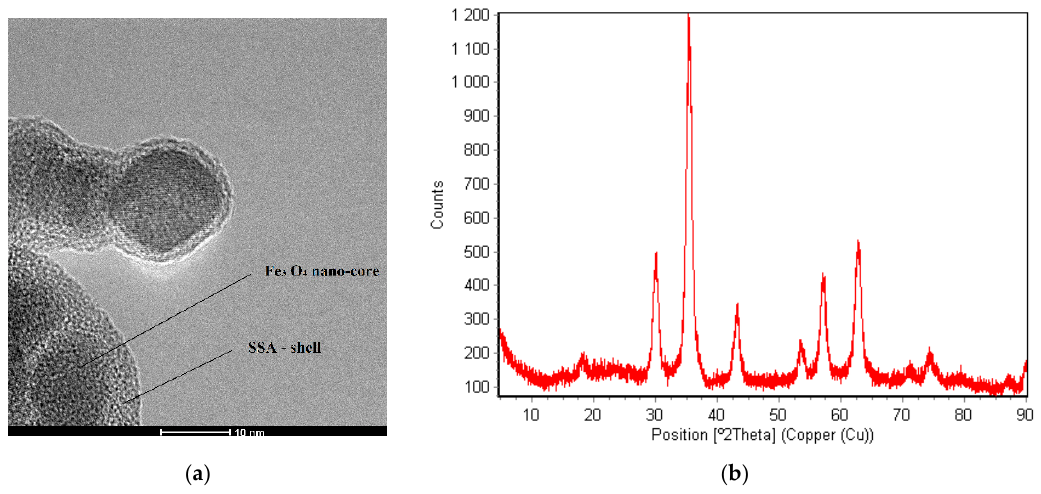
Figure 4. ( a ) The transmission electron microscopy (TEM) image of the synthesized Fe 3 O 4 nanoparticles, to which the SSA molecules were attached as external shells; ( b ) X-ray diffraction (XRD) pattern of the nanofilm of the Fe 3 O 4 –SSA nanoparticles deposed by dip-coating.